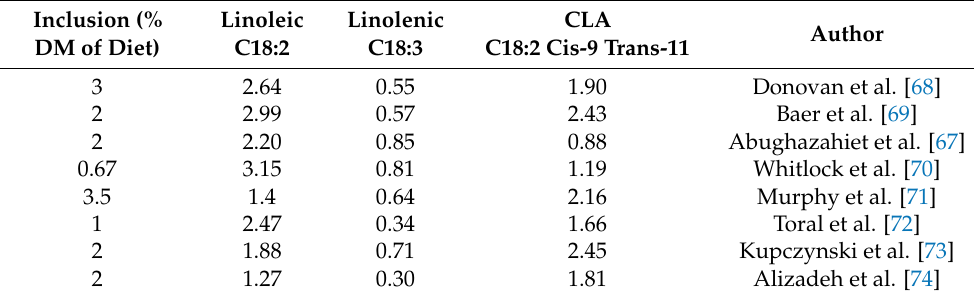
Table 3. Contents of linoleic acid, α -linolenic acid, and CLA in cow’s milk (g/100 g of fat) using fish